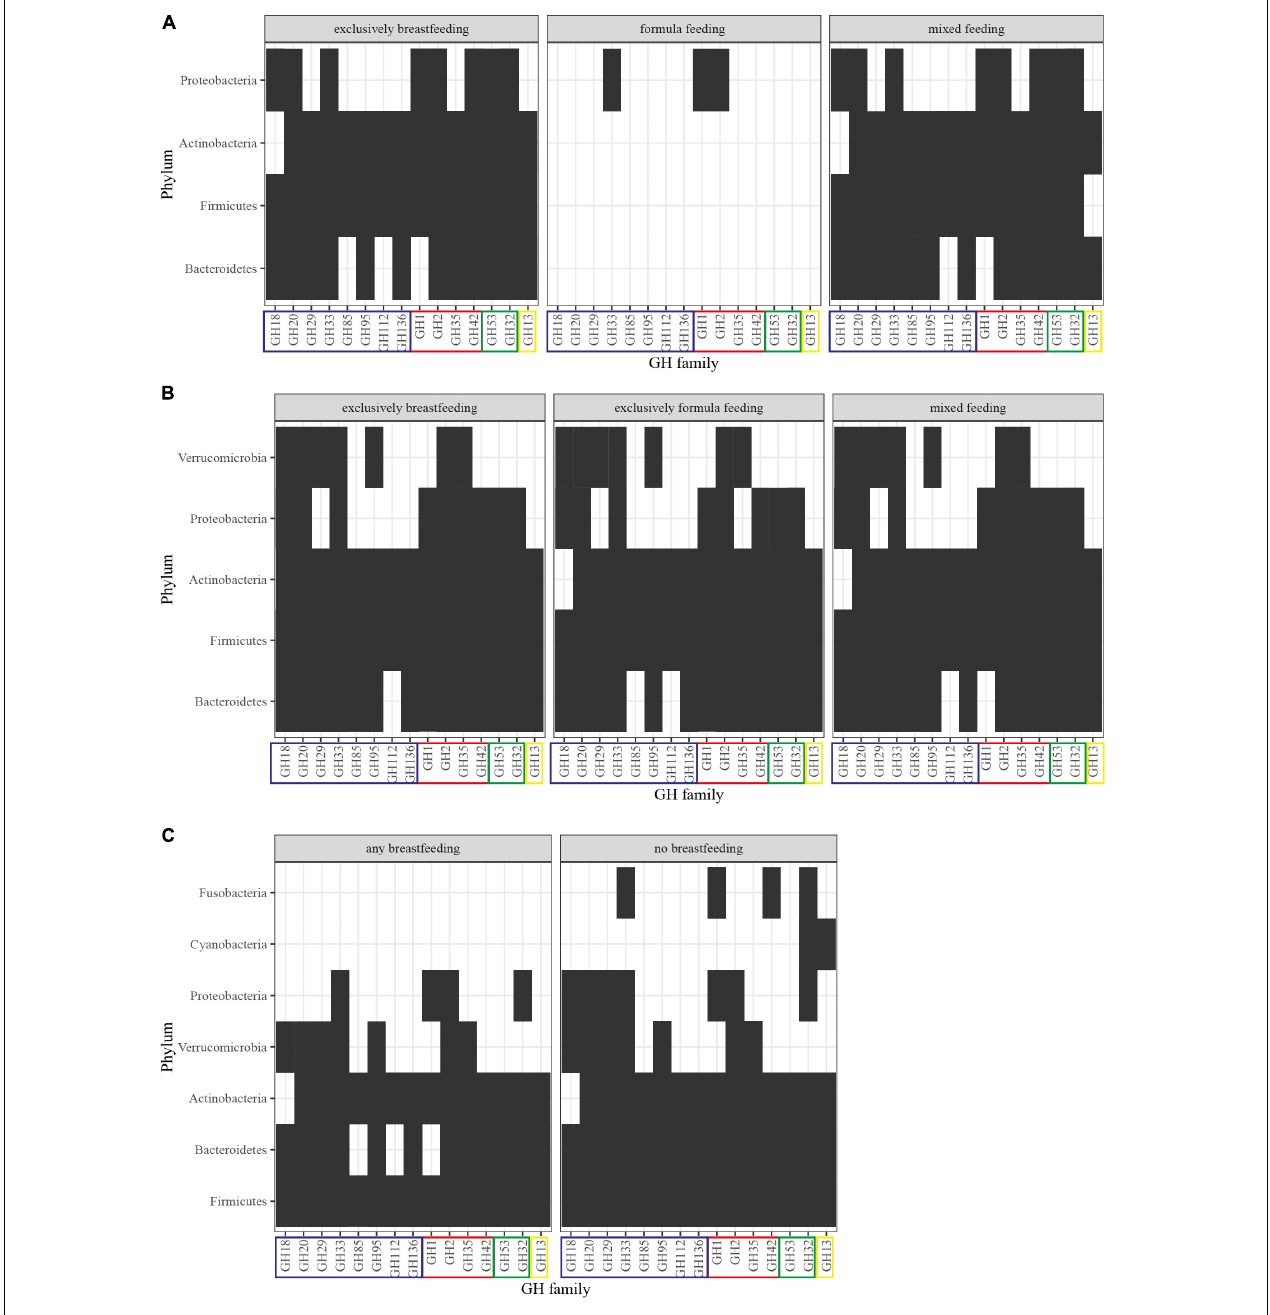
FIGURE 3 | GH profiles per phylum and feeding in (A) newborns, (B) 4-month-old infants, and (C) 12-month-old infants. GHs were detected in MAGs of Nayfach et al. (2019) derived from the original dataset of Bäckhed et al. (2015). The identification method was based on domain-based Hidden Markov Models against the dbCAN CAZyme domain HMM database (Lombard et al., 2014; Zhang et al., 2018). GHs are grouped into: (blue) HMO-related, (red) HMO- and GOS-related, (green) GOS-related, (yellow) FOS-related. Presence of the GH family is signified with a black box and abscence with a white